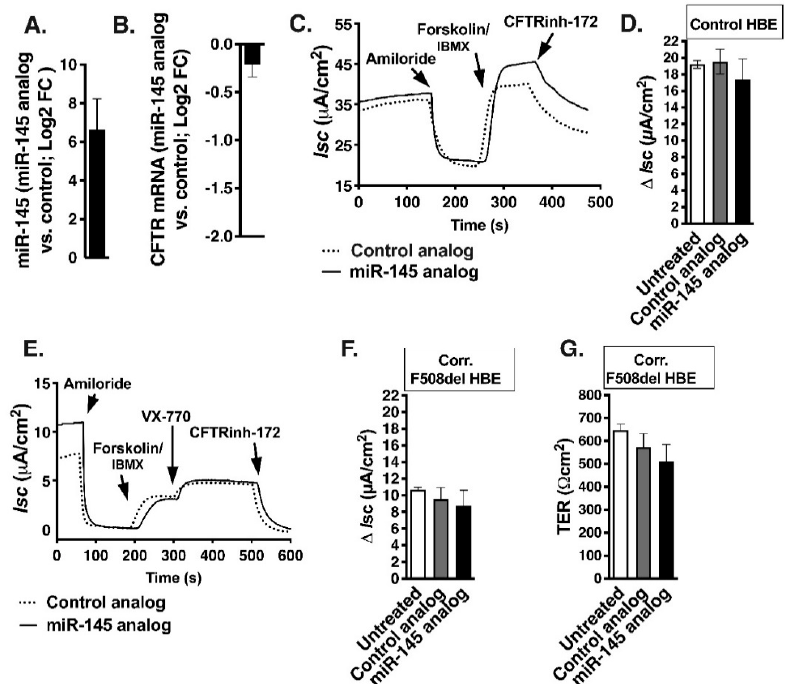
Figure 5. Increasing miR-145 levels by synthetic miR-145 analog did not change CFTR mRNA expression and CFTR-mediated I sc in control HBE cells or F508del HBE cells rescued by correctors C18 / C002 (Corr. F508del HBE). Cells were treated with miR-145 analog or control analog for 48–72 h. ( A ). qRT-PCR experiments demonstrating that miR-145 analog increased the total cellular miR-145 level compared to control analog. Expression of miR-145 after miR-145 analog treatment was normalized to U6 snRNA and expressed as Log2 FC versus control analog. ( B ). qRT-PCR experiments demonstrating that